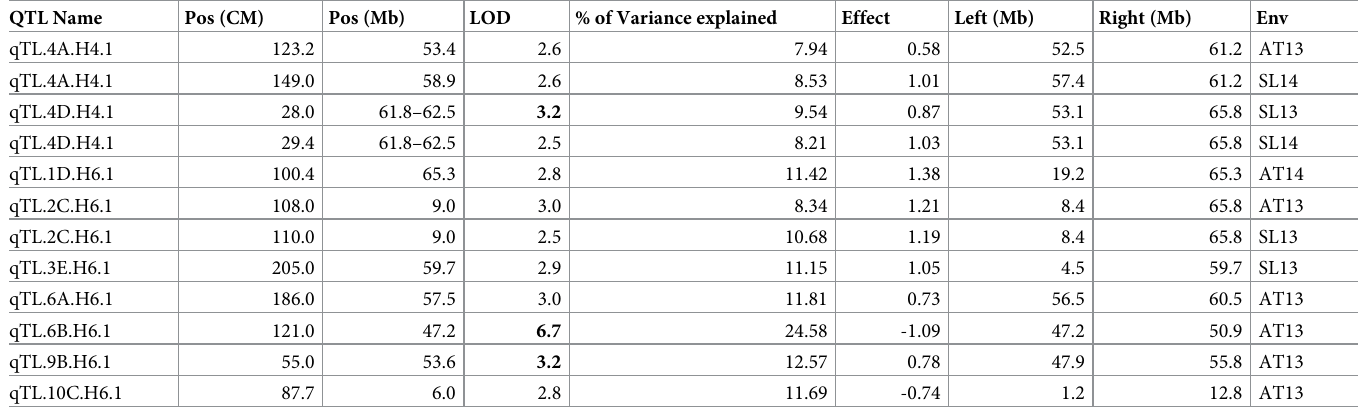
Table 1. Parameters of TL (mature tillers) QTLs from interval mapping of the H4 and H6 SBSH-BC 1 F 2